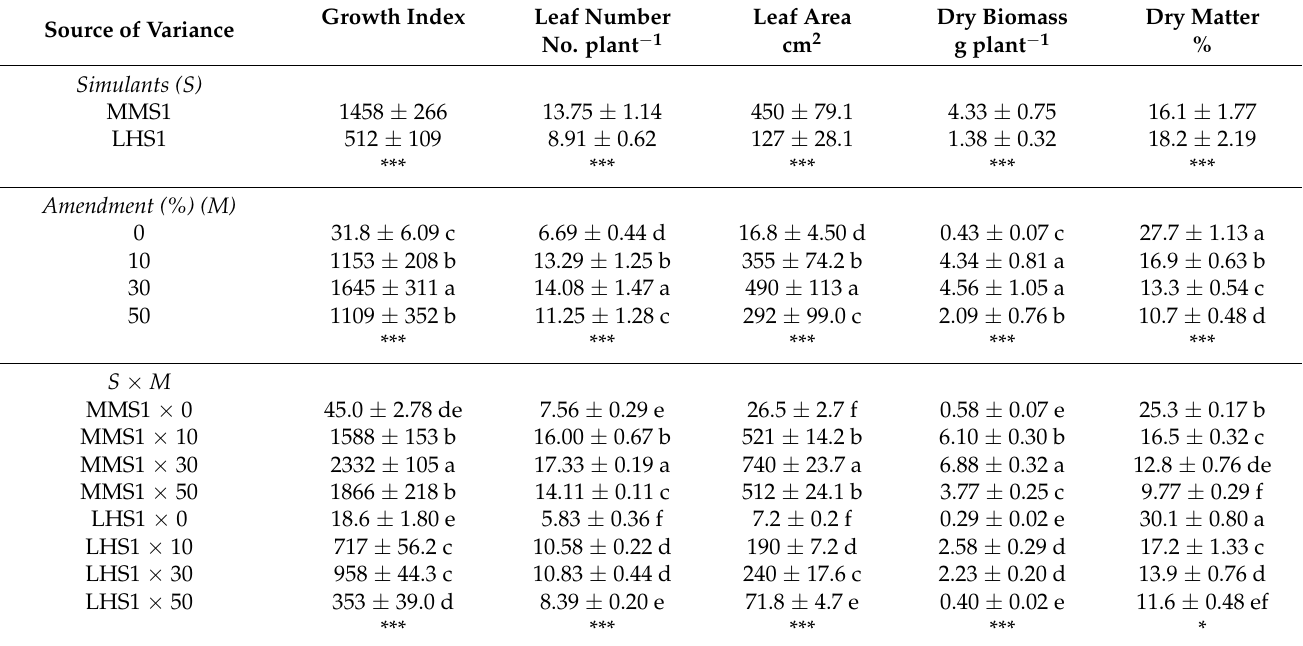
Table 1. Foliar biometric parameters in different mixtures of MMS-1 or LHS-1 simulants and